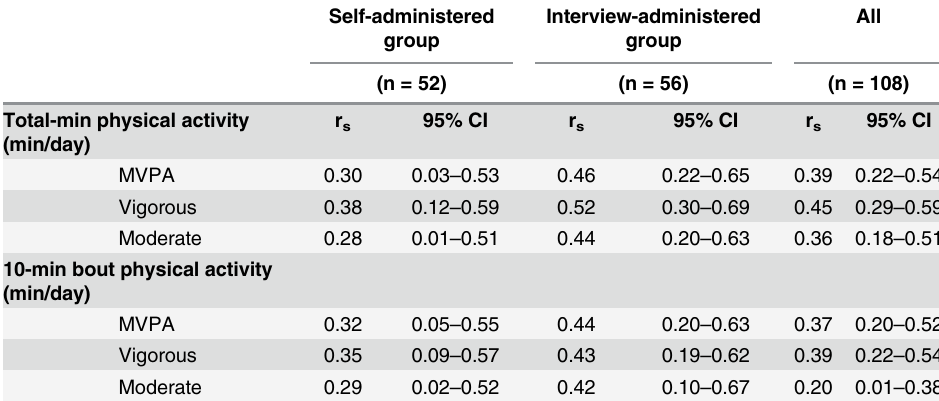
Table 5. Spearman correlation between the GPAQ and accelerometry-based summary estimates of physical activity level (min/day), according to self- and interviewer-administered